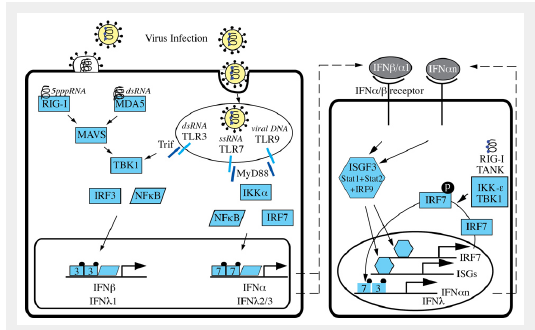
MyD88-IKKα pathway to activate IFN gene